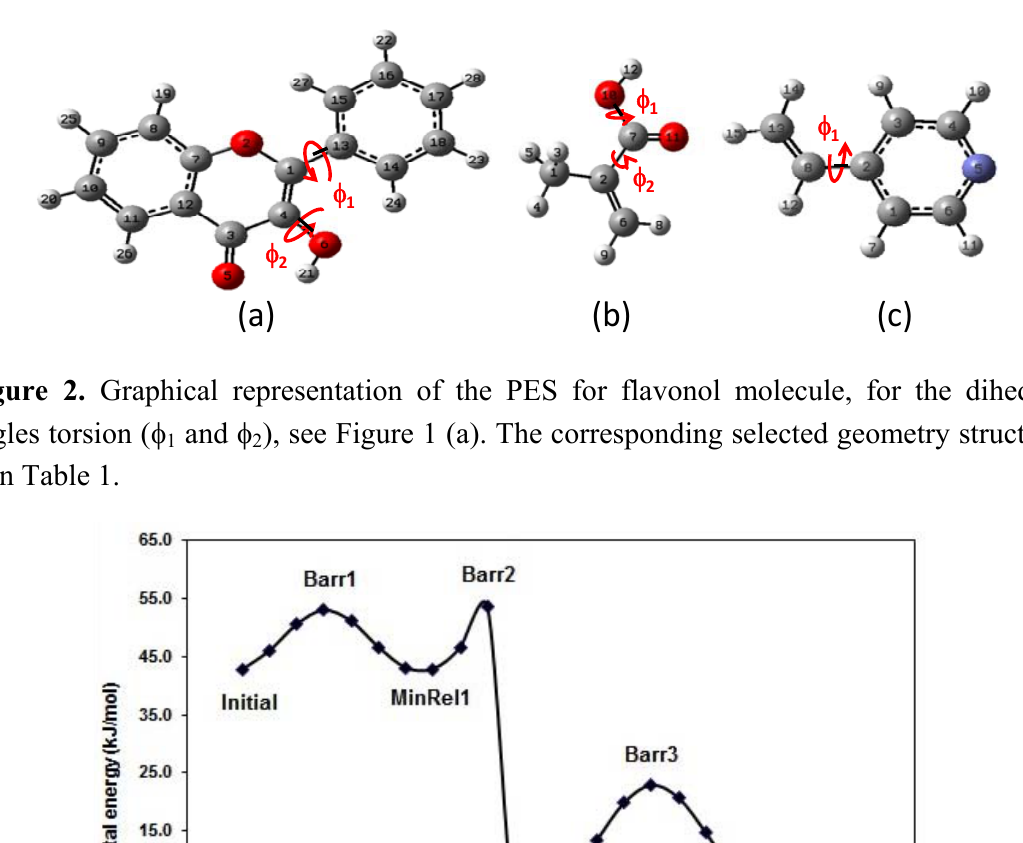
and φ . (a) Flavonol (FL), (b) methacrylic acid (MAA) and (c) 1 2